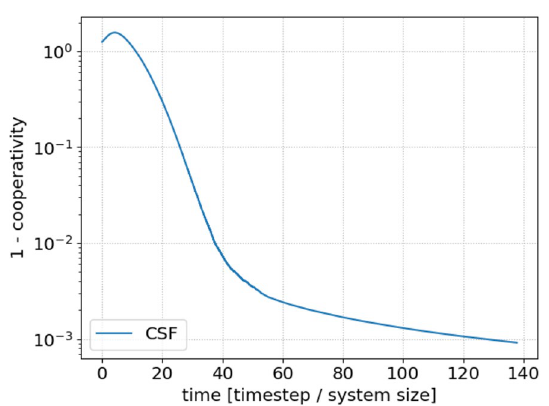
Figure 3. Logarithmic plot for a long range simulation of the average cooperativity in a standard clustered scale free network. We see that there is a critical slowing down at extremely homogeneous